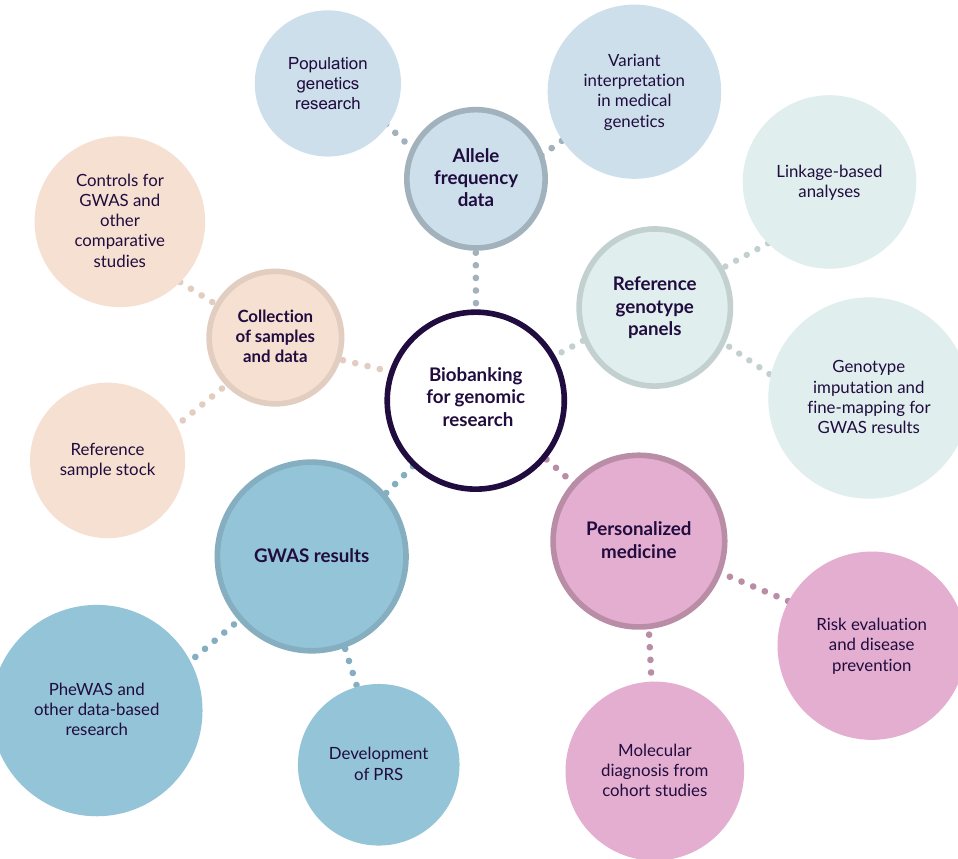
Figure 1. A diagram showing five major types of biobank applications for genomic research and medical